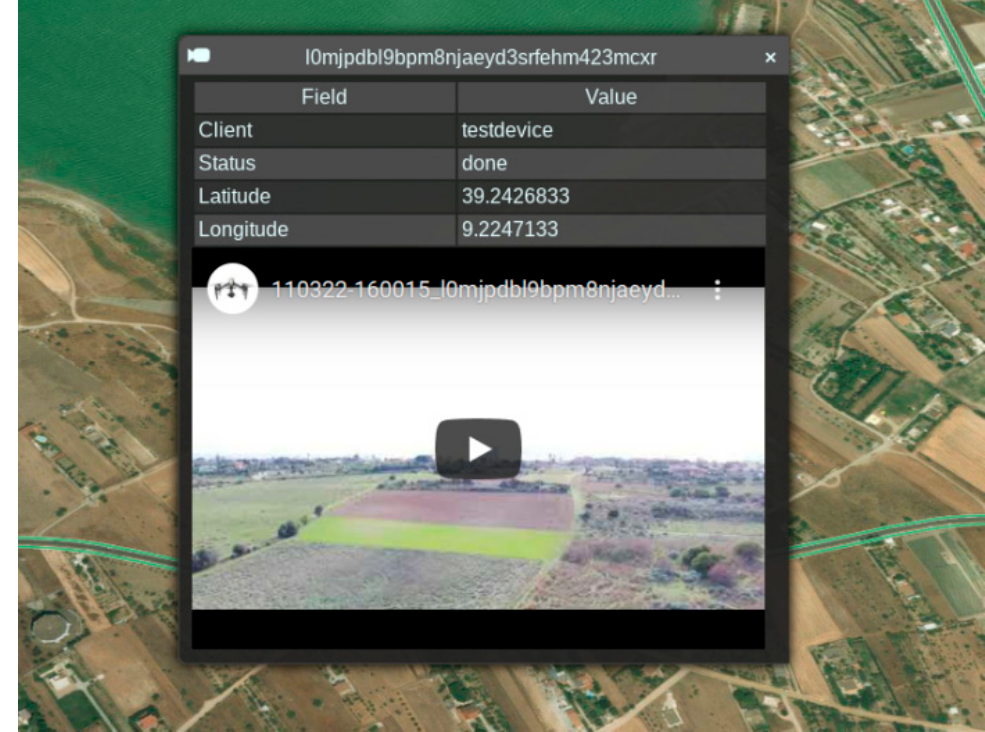
Figure 13. When the mission ends, the video is also made available on the platform.